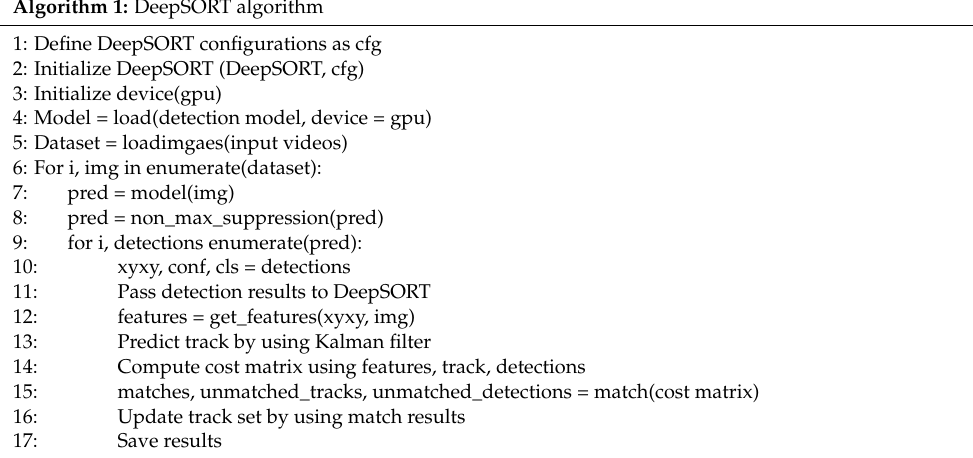
Algorithm 1: DeepSORT